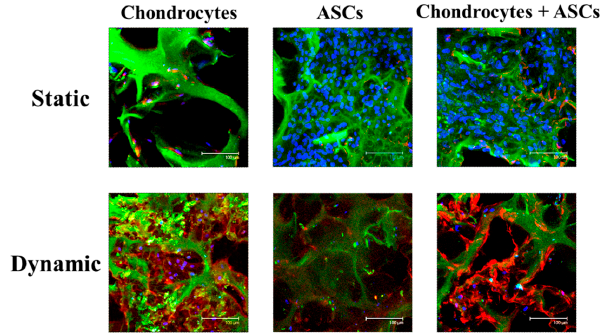
Figure 6. Immunofluorescence staining of cells/scaffold constructs when chondrocytes, ASCs or chondrocytes + ASCs were cultured in cryogel scaffolds for 14 days under static or cyclic compressive loading (frequency = 1 Hz, strain = 20% and duration = 3 h/day) conditions. Cell number: 10 5 chondrocytes/scaffold for the chondrocytes group; 10 5 ASCs/scaffold for the ASCs group; 5 × 10 4 chondrocytes/scaffold and 5 × 10 4 ASCs/scaffold for the chondrocytes + ASCs group. Blue: cell nucleus (DAPI); red: Col II (Cy 3); green: gelatin (FITC); Scale bar = 100 µm.